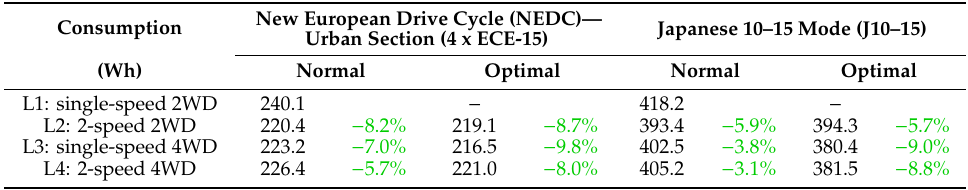
Table 6. Energy consumption results along the selected driving cycles, and their percentage di ff erence withrespecttothoseofthesingle-speed2WDEV(L1); negativedi ff erences, implyinglowerconsumption, are in